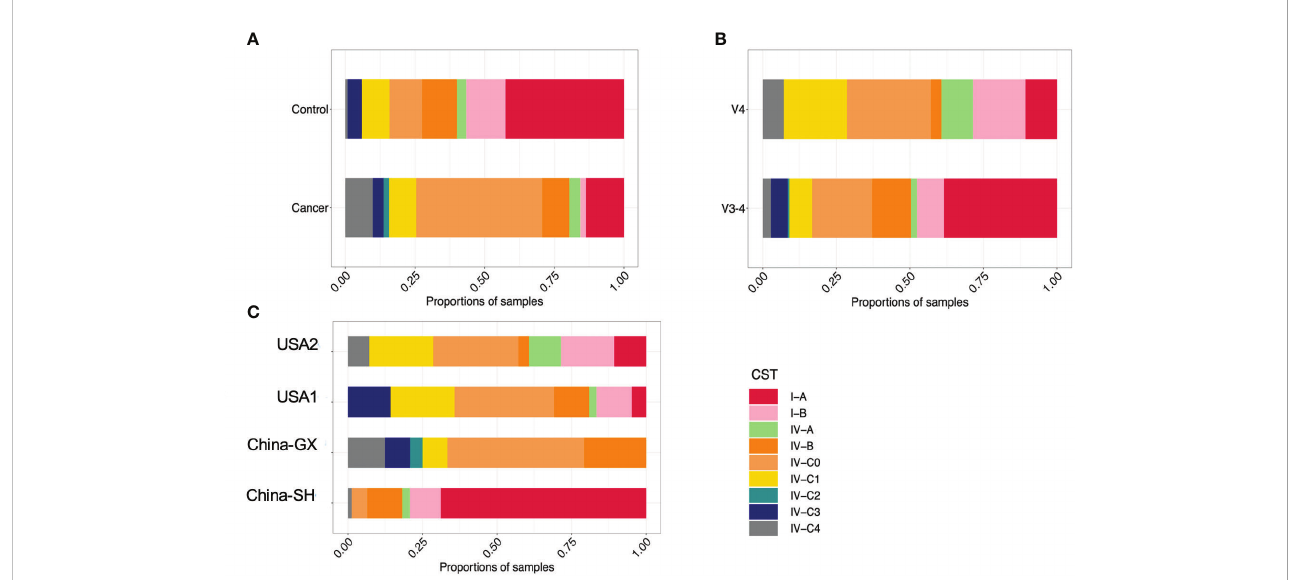
FIGURE 2 The proportions of samples assigned to each CST in samples grouped by disease (A) , study (B) and hypervariable regions (C)